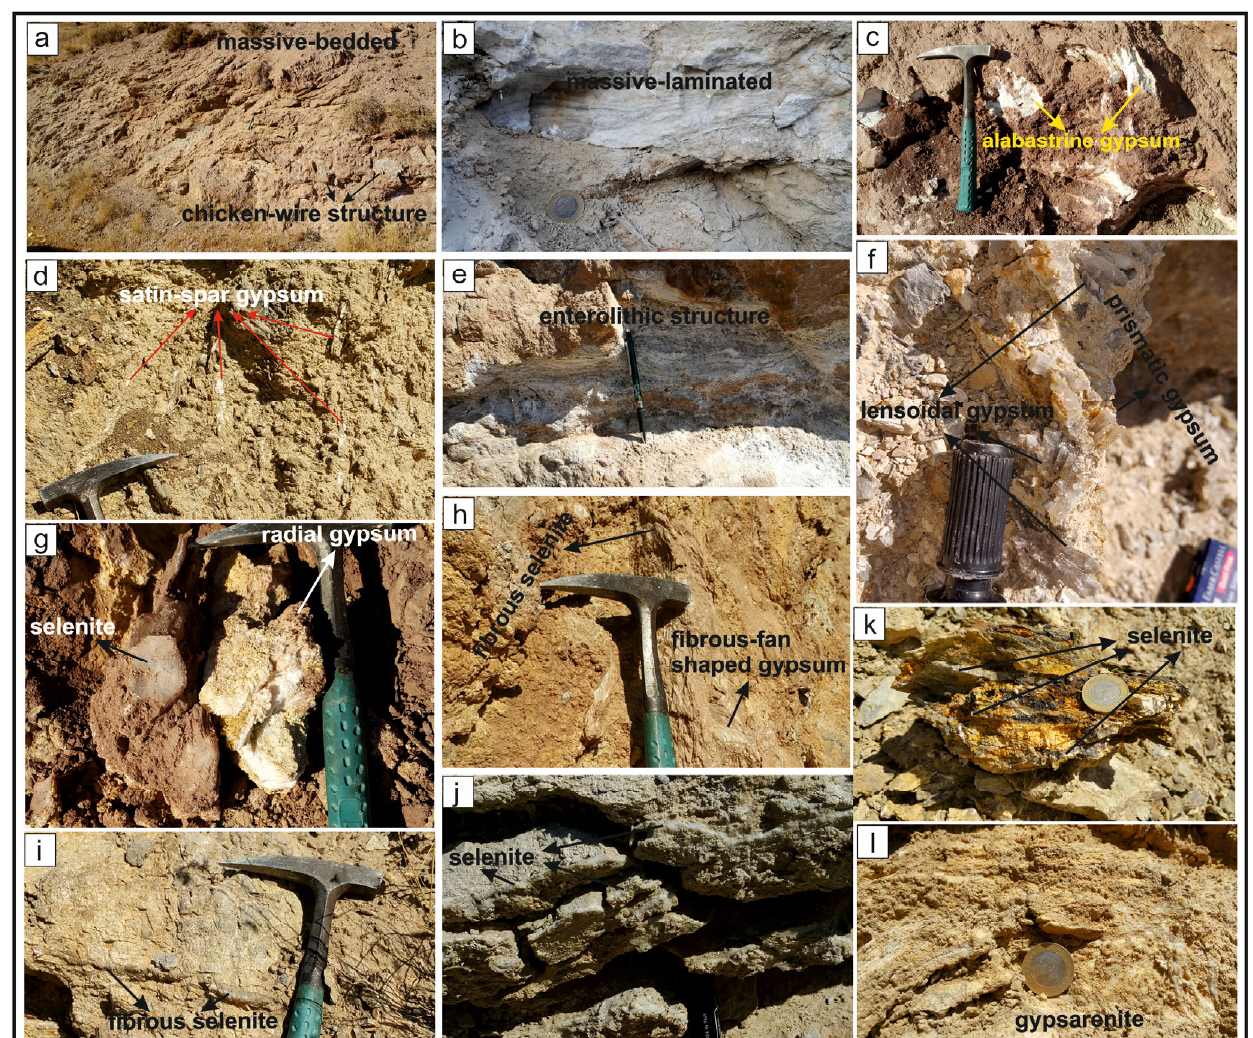
Figure 3. Sedimentologic aspects of the Köprüa ğ z ı evaporites. ( a ) Massive-bedded secondary gypsums with interbedded clay and carbonated and chicken-wire structures; ( b ) clay laminated-undulated massive secondary gypsum; ( c ) milky-white color alabastrine massive gypsum in the red–brown mudstone; ( d ) satin-spar gypsum developing perpendicularly to the vein wall, filling the limestone cracks; ( e ) undulated-laminated secondary gypsums and enterolithic structures; ( f ) prismatic-lensoidal selenitic gypsums filling the limestone cracks; ( g ) euhedral gypsum and partially anhydritized radial selenitic gypsum; ( h ) fibrous and fibrous-fan shaped selenitic gypsums (some parts partially and completely anhydritized); ( i ) fibrous selenite within the dolomitic limestone cavities; ( j ) partly anhydritized selenite interbands in the carbonate rock; ( k ) selenite interbands containing Fe-oxide and sulfur alteration; ( l ) gypsarenites anhydritized in some places, containing ripple mark